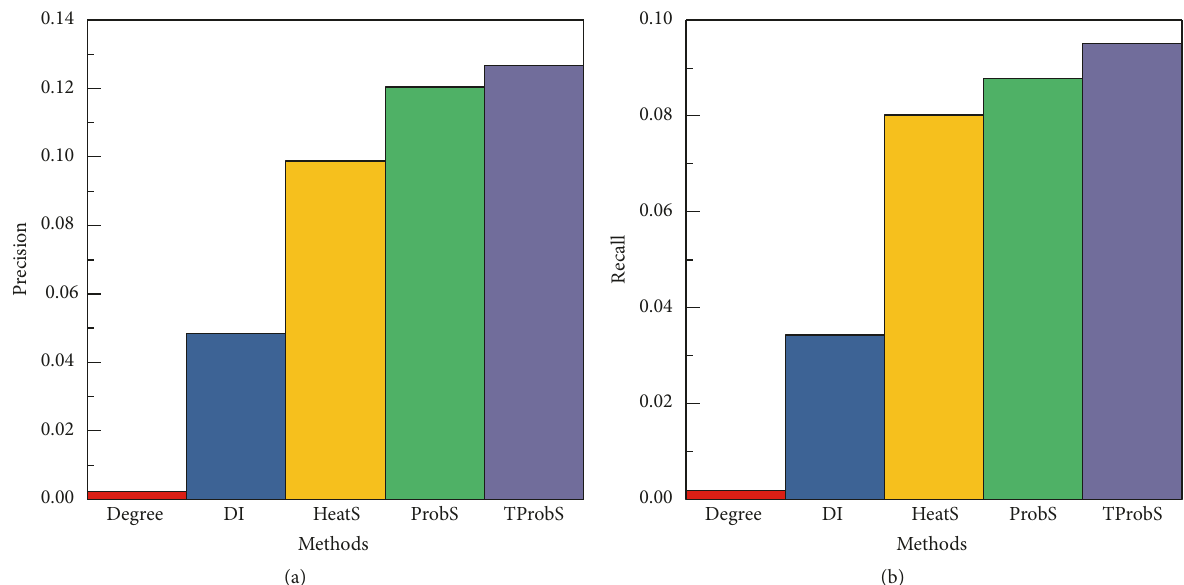
Figure 1: A comparison of Recall and Precision for the five algorithms. The recommendation is performed at year 𝑇 for year 𝑇 + 5 , with 𝑇 ranging from year 2001 to 2010. The results shown are averaged over this time period. For TProbS, we set a value of 𝜃 = 0.2 . The Degree method simply ranks the products according to their degree. All subsequent experiments were based on this recommendation.